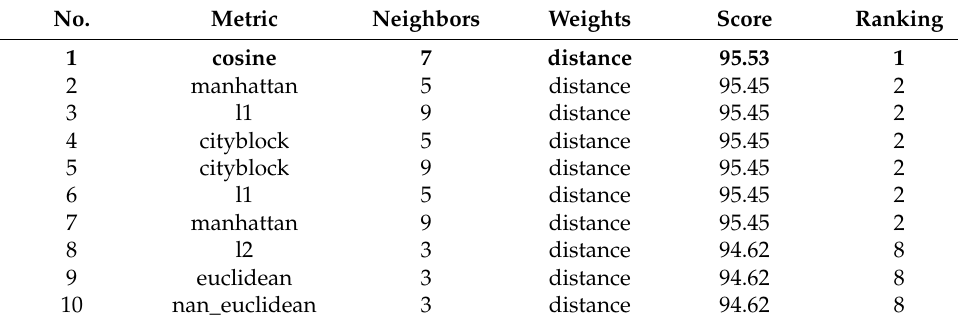
Table 7. K-Nearest Neighbors hyperparameter-tuning results.